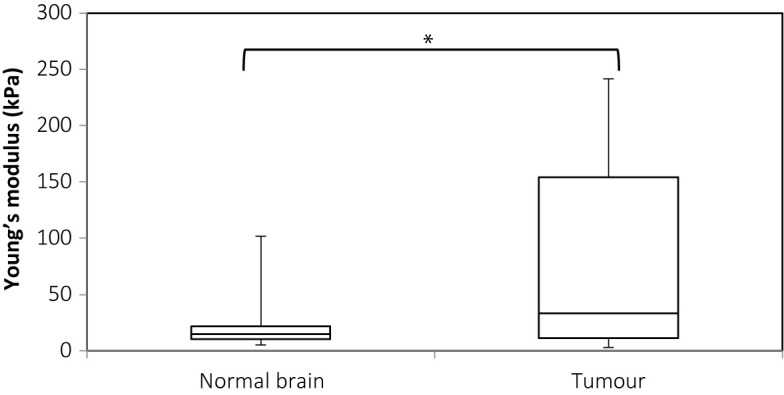
Box and whiskers plot for Young’s modulus measurements of normal brain and tumor. The upper and lower bounds of the box were the third and first quartiles, respectively, while the line within the box was the median. The upper and lower whiskers were maximum and minimum values, respectively. *There was a significant difference between the two groups (p = 0.003, Wilcoxon’s signed-rank test).